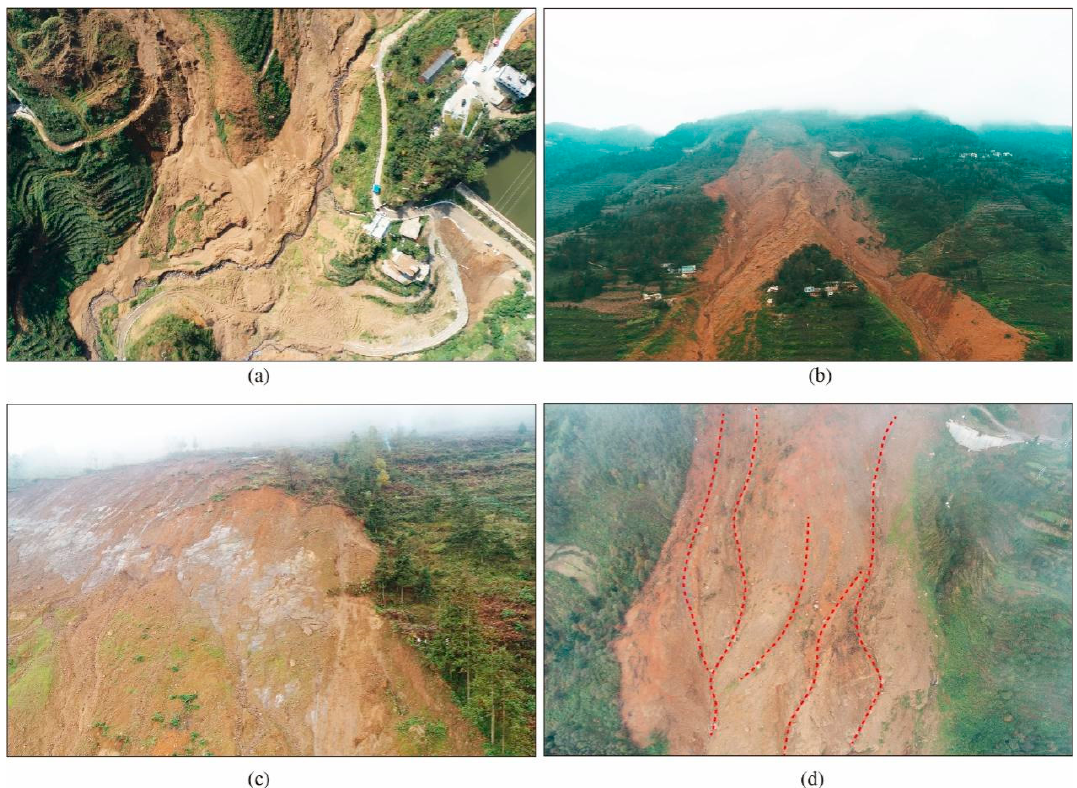
Figure 5. Field photos of the Shuicheng landslide: ( a ) landslide accumulation areas in Shuicheng. ( b ) Subsequent landslide movement along the gullies after impacting the hard body. ( c ) Photos of the back wall of the source area. ( d ) Scratches in the shoveling and scraping area (dotted lines denote scraping marks).